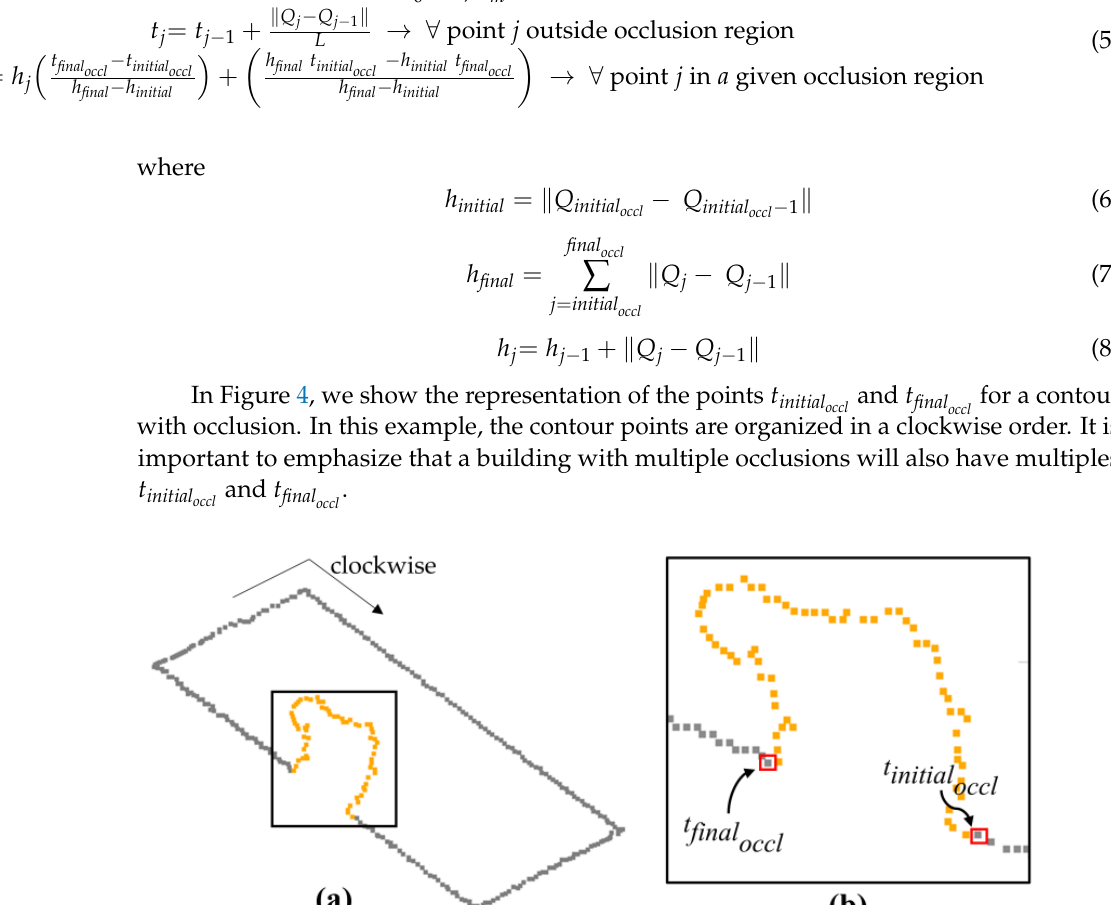
initial occl occl